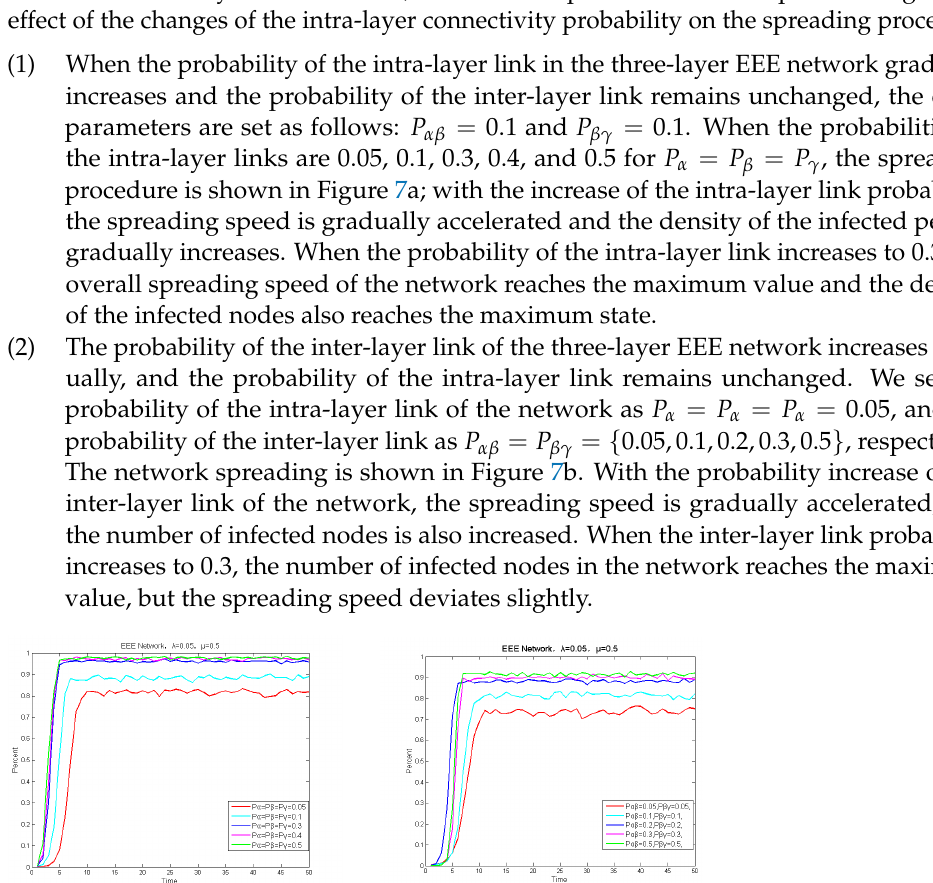
Figure 7. Influence analysis of the three-layer complex network EEE’s parameters on spreading procedure, ( a ) shows the influence of the intra-layer link probability, ( b ) shows the influence of the inter-layer link probability